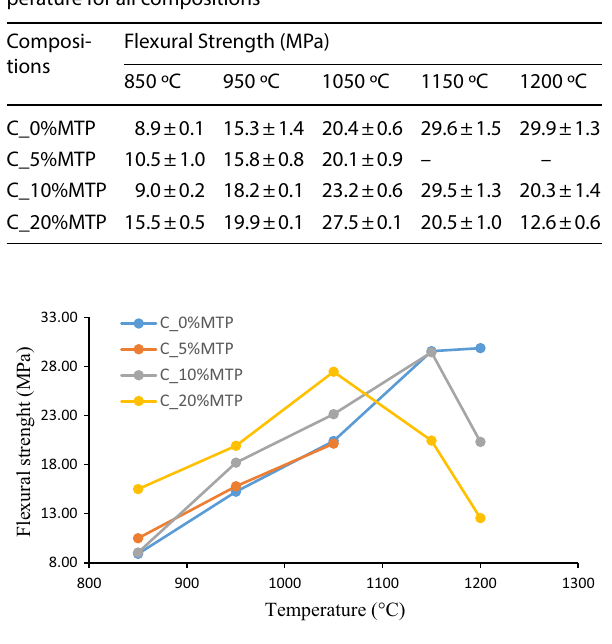
Fig. 9 Flexural strength behavior with the increase of firing tem- perature of ceramic compositions